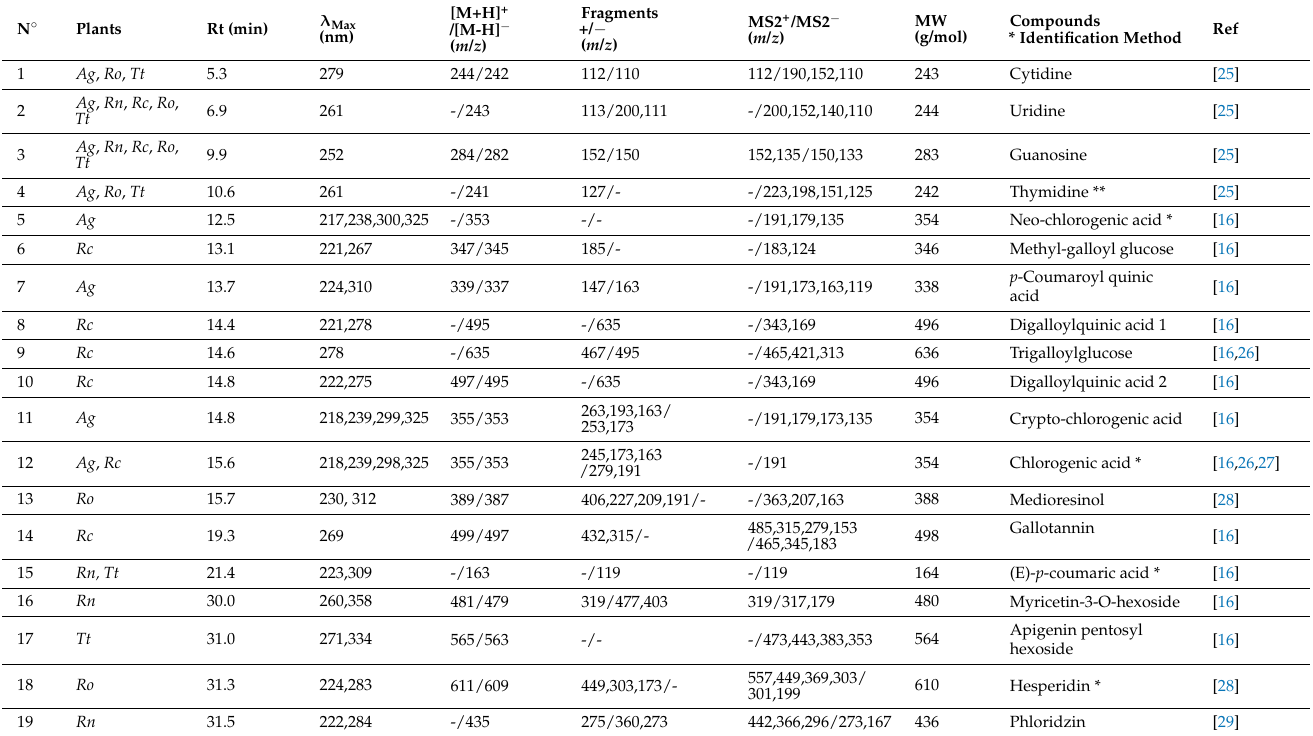
Table 2. HPLC/UV (254 nm) and MS1, MS2 data obtained after negative and positive ionization of CBMs of Alnus glutinosa ( Ag ), Ribes nigrum ( Rn ), Rosa canina ( Rc ), Rosmarinus officinalis ( Ro ) and Tilia tomentosa ( Tt